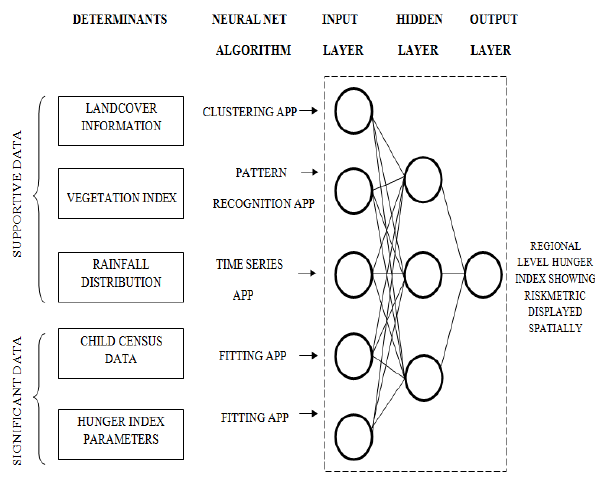
Figure 2. Overall workflow